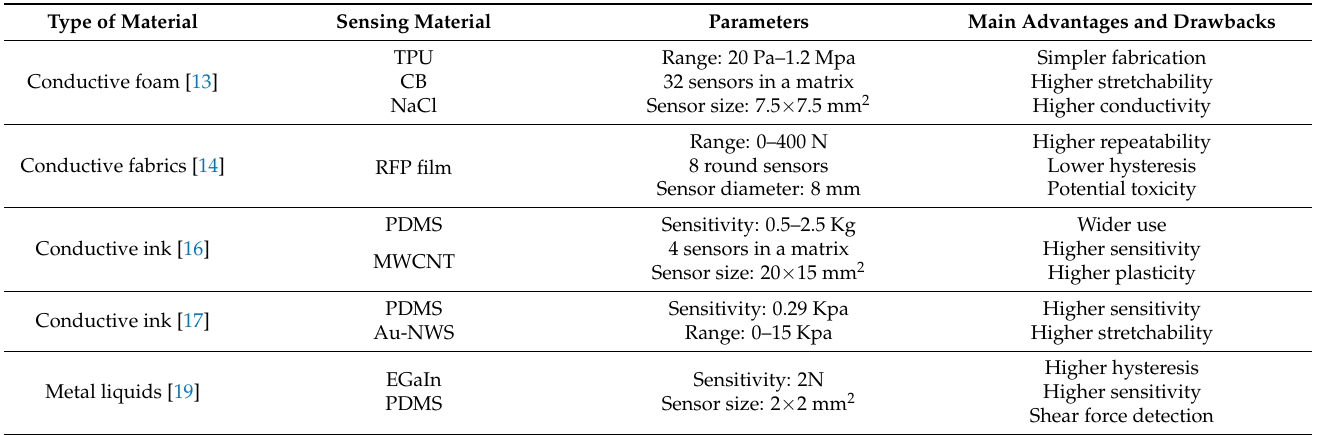
Table 1. Brief description of sensors outlined in Section 3.1. Conductive ink-based sensors are used more often because of their higher sensitivity and stretchability. Other types of materials have diverse merits such a non-hysteresis, simple fabrication, and ability to detect shear